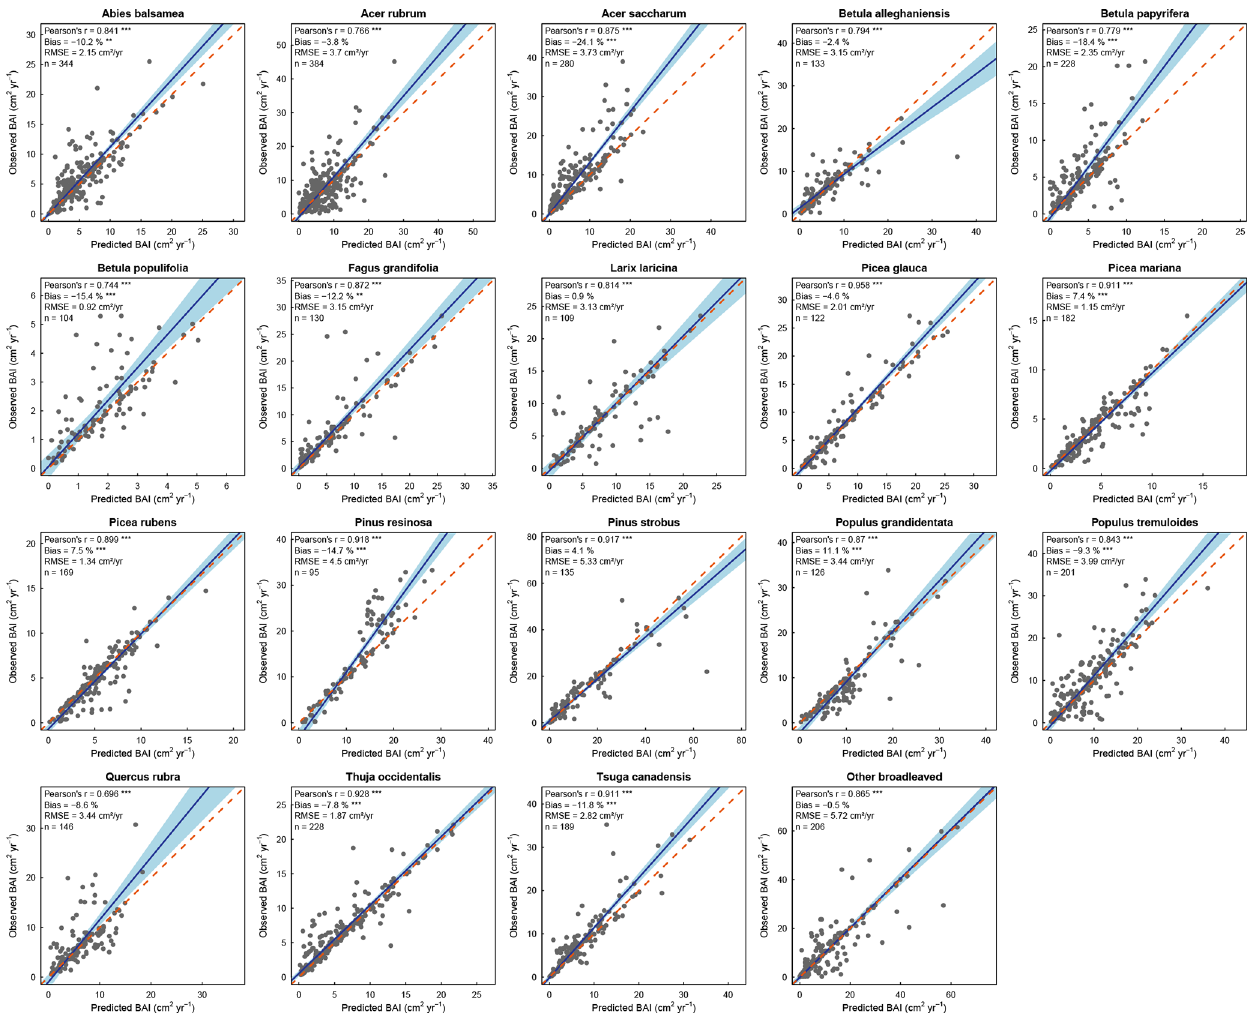
Figure 4. Observed versus best predicted basal area increment for each species (or group of species) using the evaluation dataset. Each dot represents the best prediction within the 10 simulations for a single tree. The blue line represents the Deming regression between observed and predicted values, the light-blue area is the confidence interval at 95%, and the dashed red line corresponds to the 1 : 1 line. Model performance is indicated using Pearson’s r ( p value: ∗∗∗ < 0.001), the relative bias (paired t test – p value: ∗∗∗ < 0.001; ∗∗ < 0.01), and the